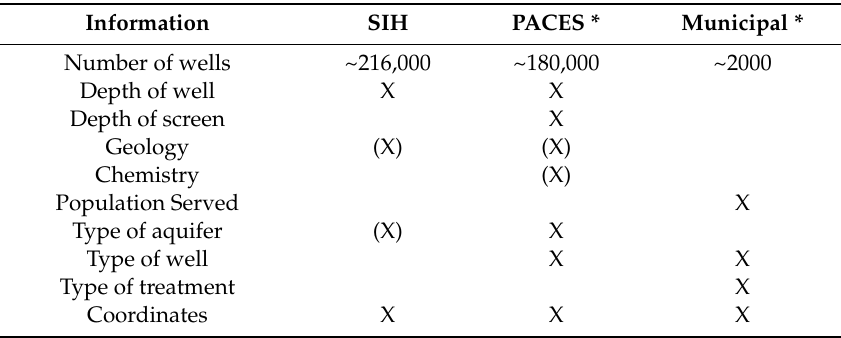
Table 1. Summary of data available in the databases. Information SIH PACES * Municipal